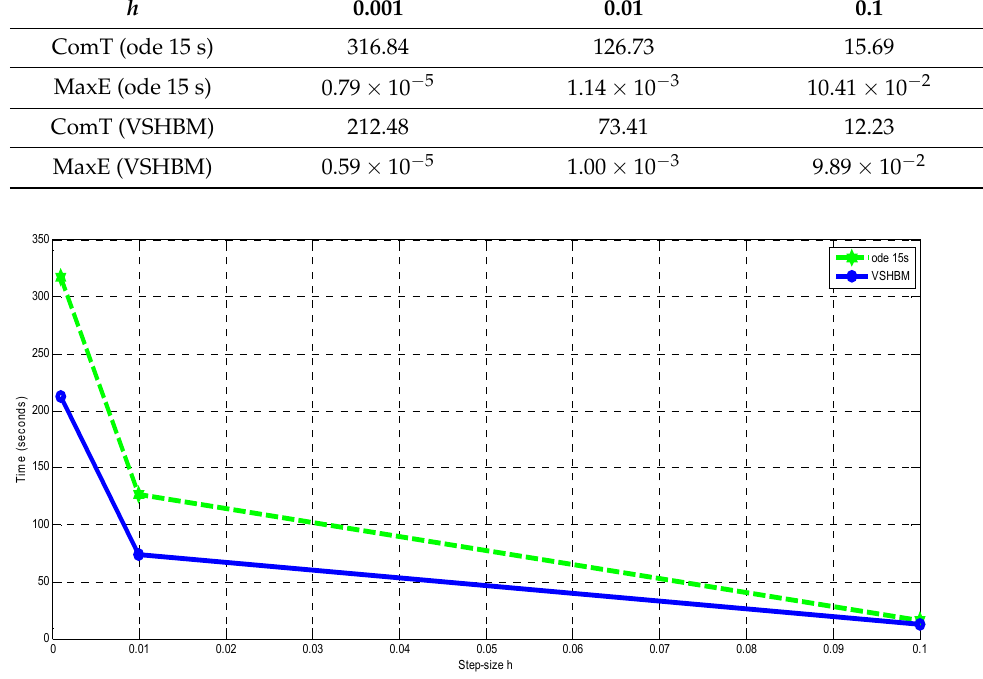
Figure 6. Comparison of computation time for constant step size h.